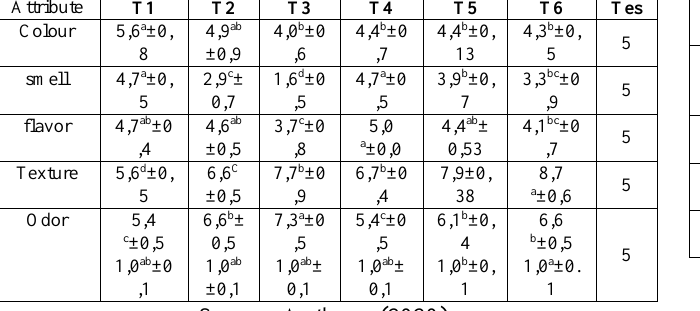
Table 2: Comparison of averages of sensory attributes between treatments.